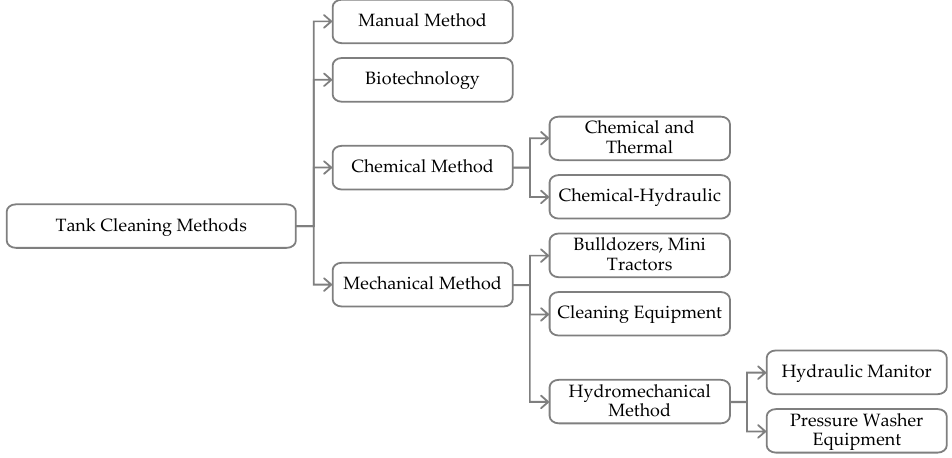
Figure 1. Tank cleaning methods. Adapted from [26].